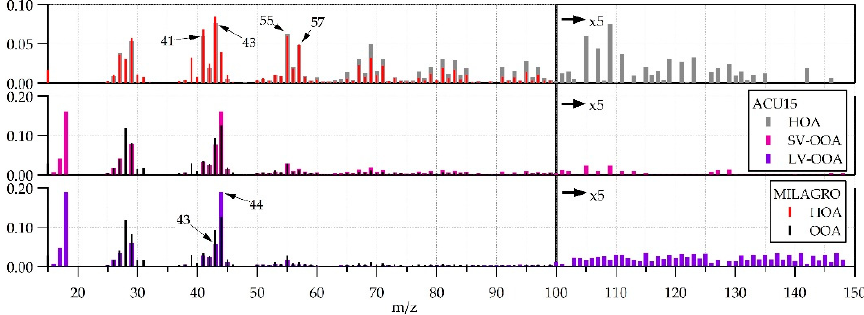
Figure 7. Mass spectra of the Positive Matrix Factorization (PMF) organic factors during ACU15 and MILAGRO (Megacity Initiative: Local And Global Research Observations) [13]. HOA: hydrocarbon-like organic aerosol; SV-OOA: semi-volatile oxygenated organic aerosol; LV-OOA: low-volatility oxygenated organic aerosol.